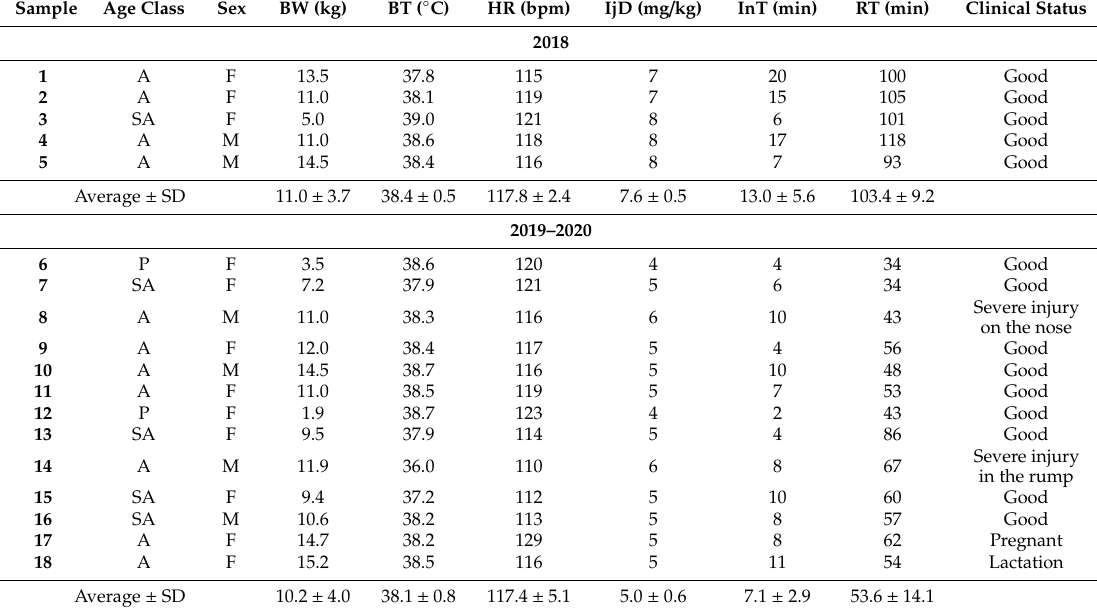
Table 1. Mean value and standard deviation of BW, BT, HR, IjD, InT, and RT of porcupines captured in 2018 and 2019–2020, respectively. Sample